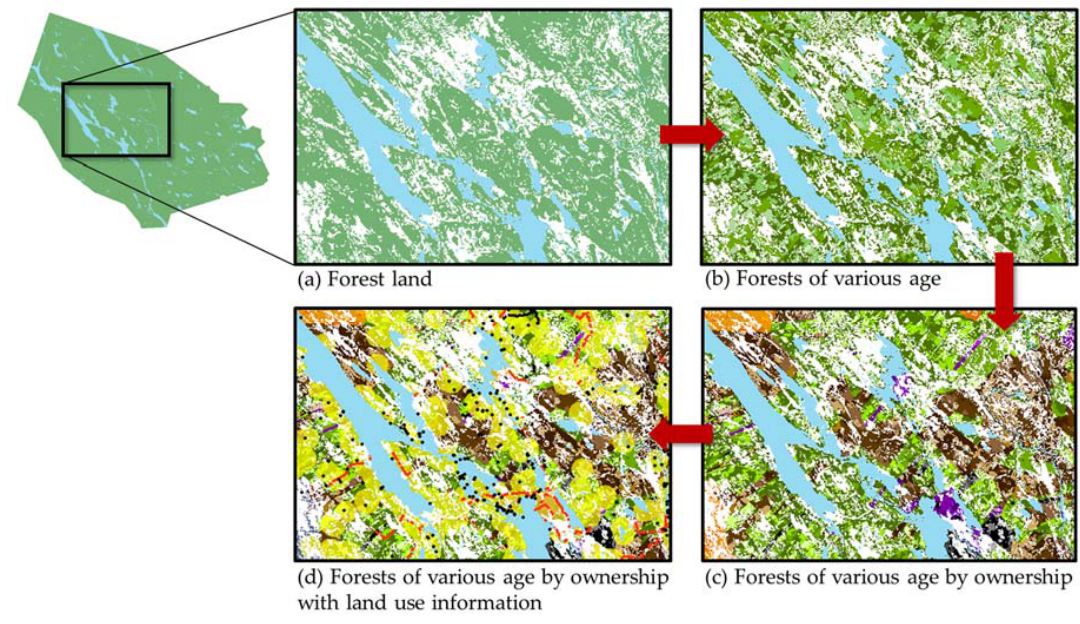
Figure 7. Maps illustrating the results from the Forest Data Assimilation Approach for our focus study area in Vilhelmina municipality, Sweden: ( a ) proportion and location of forest land; ( b ) area and location of forest land of various ages and thereby character; ( c ) area and location of forest land of various ages by ownership; and ( d ) area and location of forest land of various ages by ownership with information about the use of forest land for various purposes.